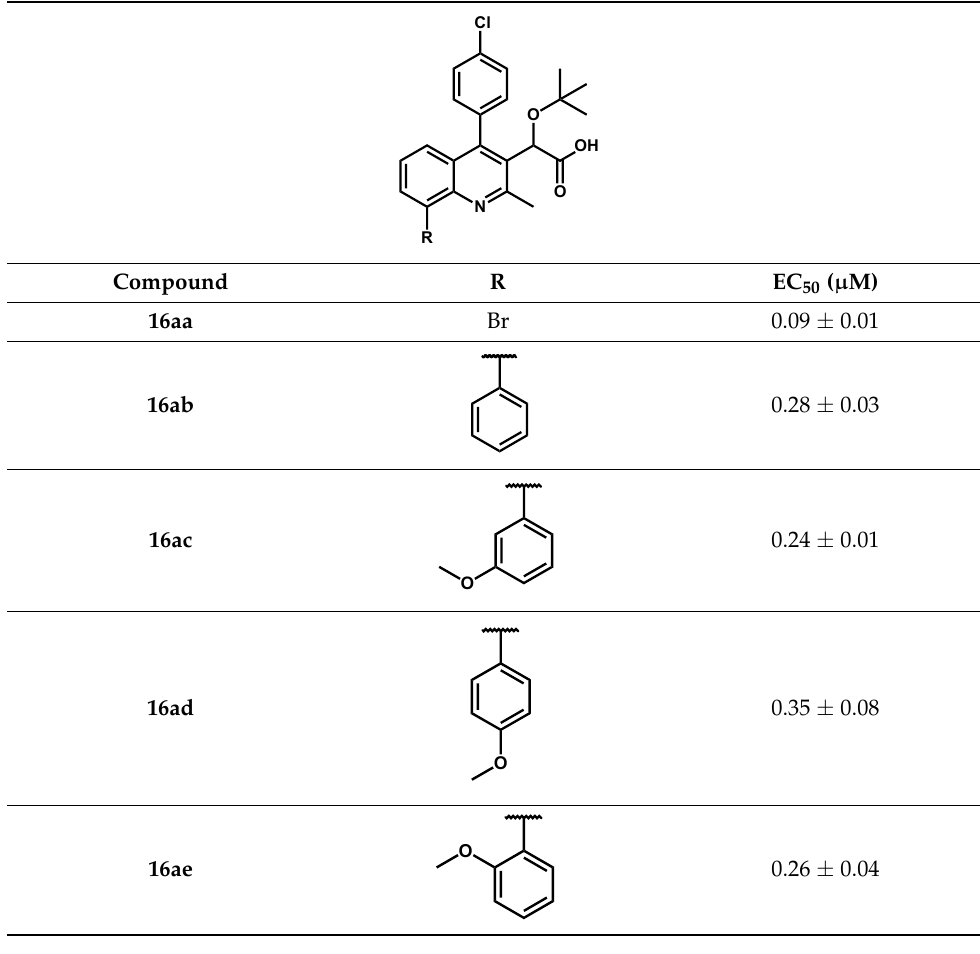
Table 3. In vitro IN multimerization EC50 activities of 8-substituted-4-chlorophenylquinolines.